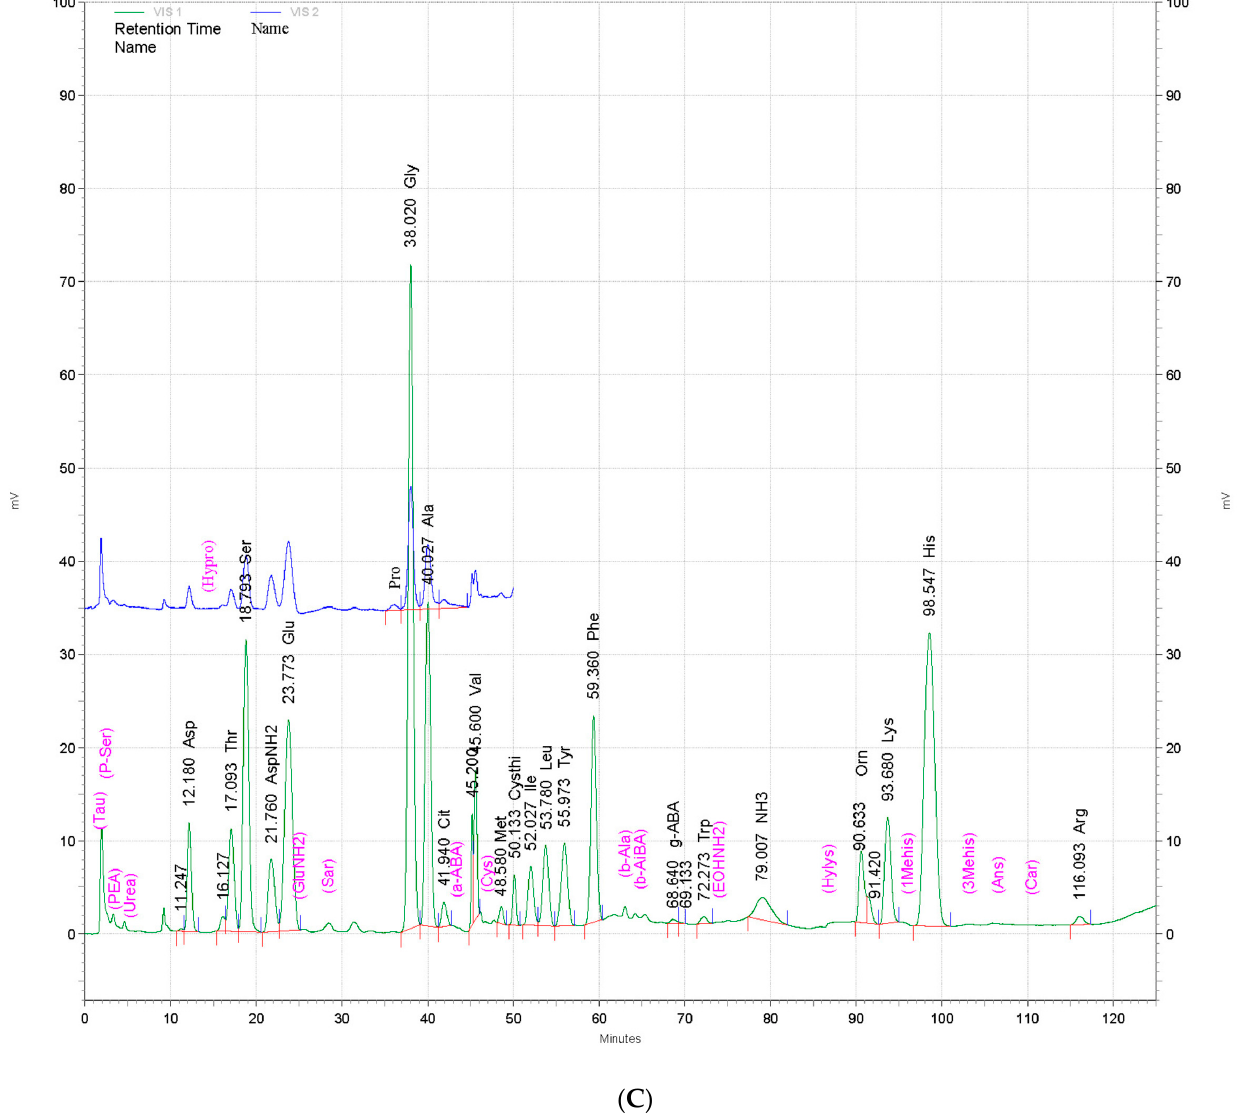
Figure 9. Amino acid composition of powdered by-products of mature silkworm larvae of ( A ) Baekokjam (SLPB), ( B ) Yeonnokjam (SLPY), and ( C ) Golden Silk (SLPG) strains. Color coded by the machine according to wavelength of the UV detector. Green color represents VIS1 (570 nm) and blue color represents VIS2 (440 nm).